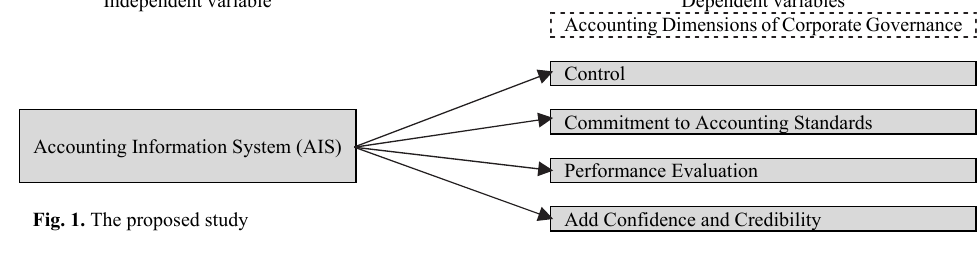
Fig. 1. The proposed